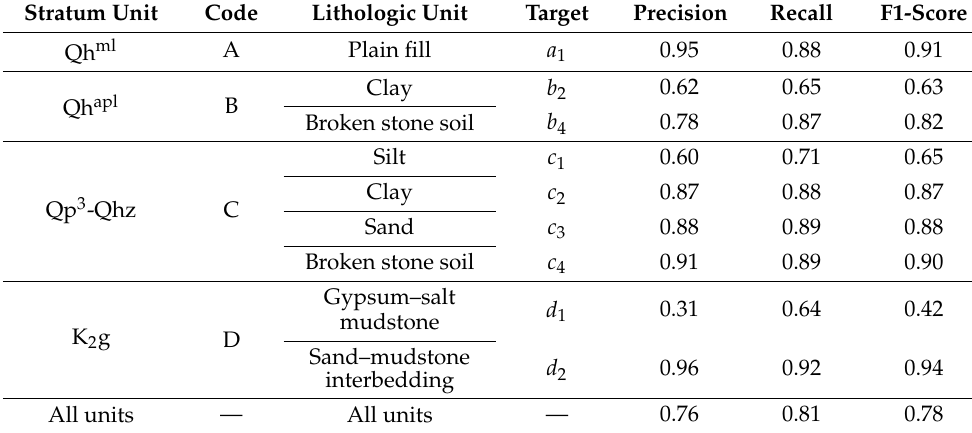
Table 3. The testing results of the lithologic